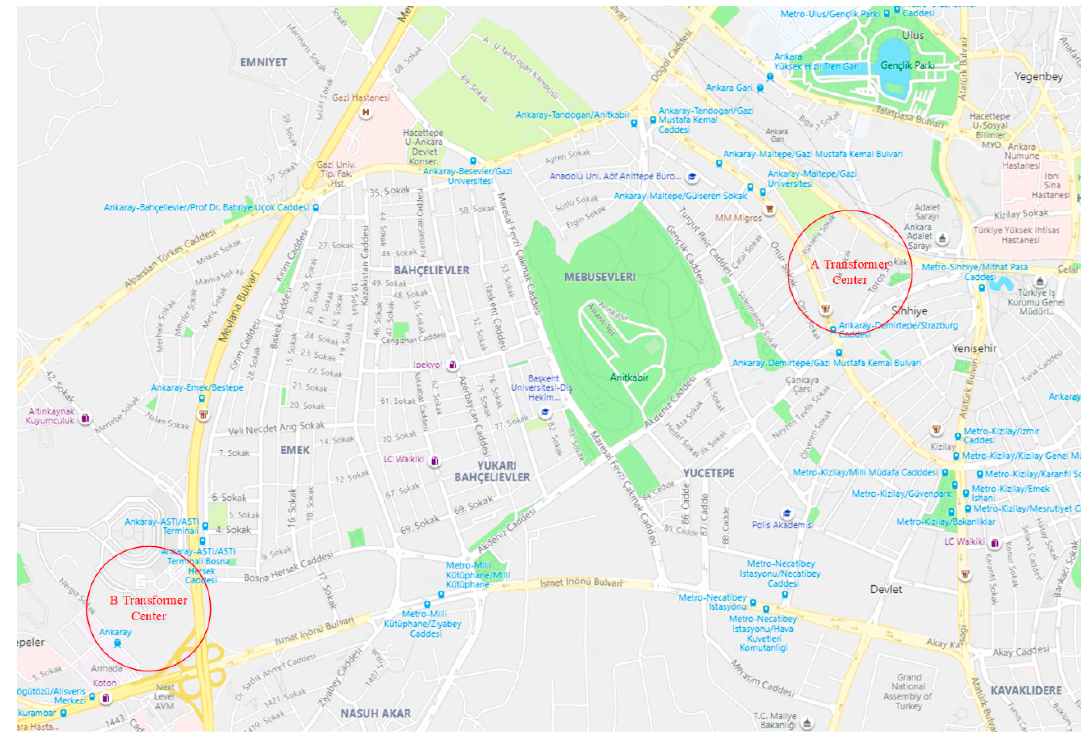
Figure 1. Map of Ankara, and area maps of the A and the B Transformer Centers [16].